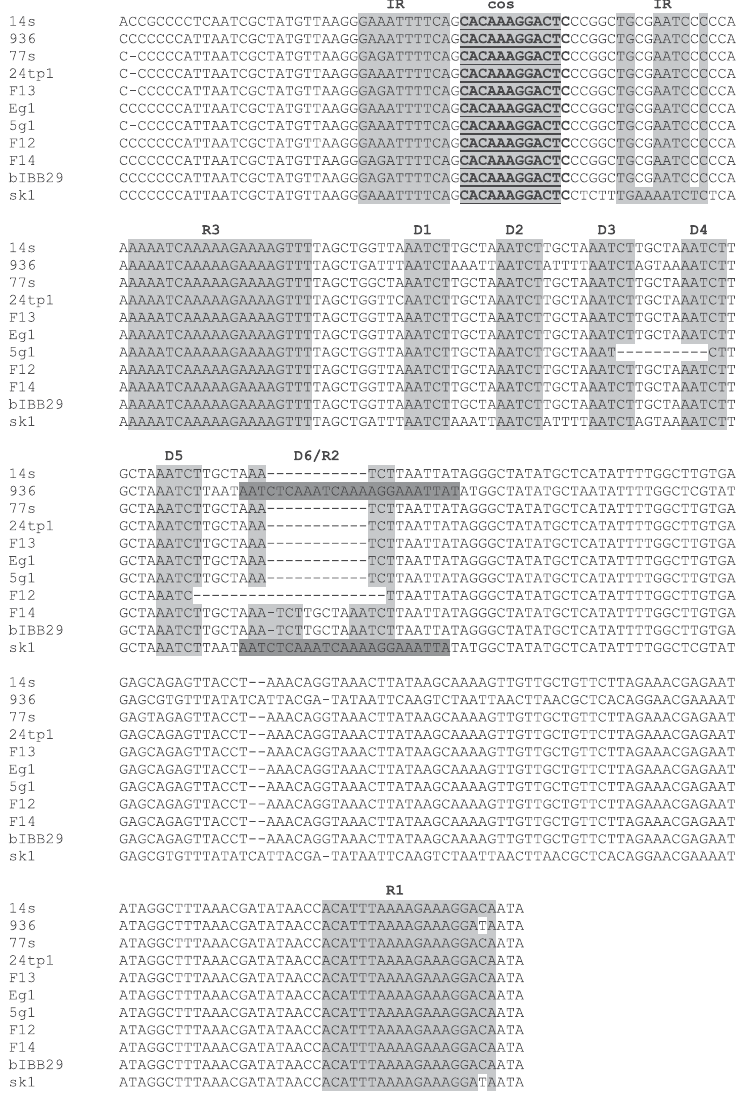
assigned functions using the BLASTp, HHPRED or HMMER tools but exhibited high homology ( > 90% identity) to proteins encoded in the same genomic positions by Lactococcus phage bIBB29, with some exceptions (Fig. 5). The middle-expressed gene region of 936-type phages is also postulated to encode proteins engaged in phage DNA replication/recombination events. For all phages sequenced in this study, this region was found to contain 4 small orfs , similar to the case in other 936-type phages 28 . Among them, the largest (483 bp), mid- orf 3, was determined to encode a putative Holliday junction resolvase (HJR) with a RuvC domain, which exhibited signif- icant homology (99% identity) to HJRs of several Lactococcus phages, including ASCC281, ASCC284, ASCC310, ASCC358 and ASCC365. Notably, in phage 14s a putative HNHE function was identified for the protein encoded by the last orf of the middle gene cluster. The hypothetical protein product exhibited high sequence identity (99%) to the HNH endonuclease of the Lactococcus phage P113G, which has a conserved HNHc superfamily zinc-binding loop domain. Similar to the case for the other HNHEs identified in the early gene regions, the best structural match for this protein was the HNH catalytic motif of Bacillus phage SPO1 I-HmuI processing endo- nuclease (E-value 1e-21). Rest of the products encoded in the middle-expressed region remain unannotated; no relevant sequence or structural homology to proteins existing in databases was noted. In 936-type phages, the late-expressed region encodes products engaged in lysis, head and tail morphogenesis and packaging. Comparative genome analysis of this region among the studied phages showed an overall high